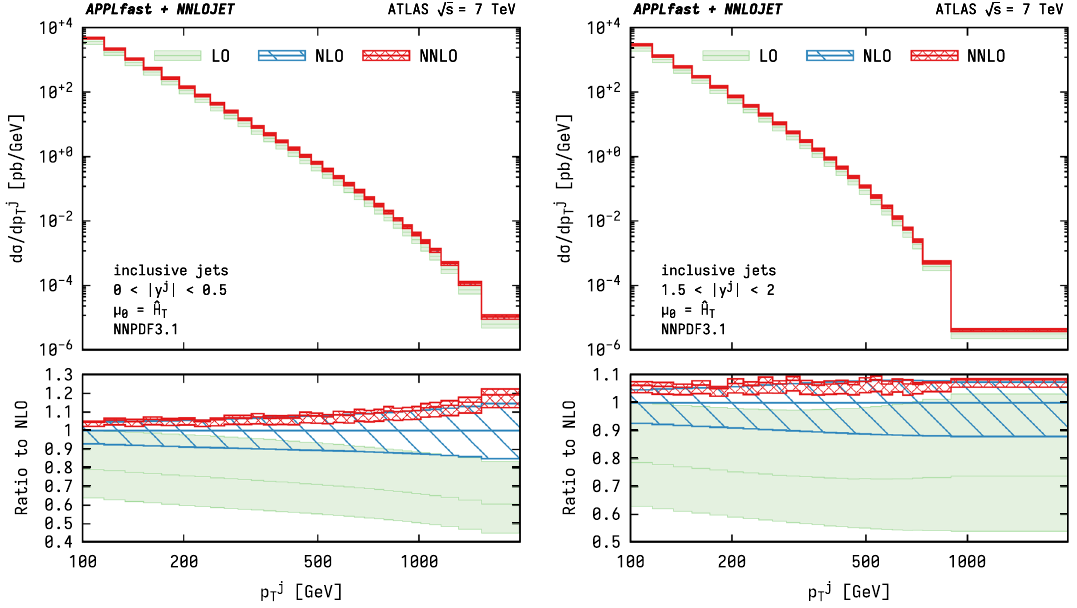
Fig. 2 PredictionsatLO,NLOandNNLOfortheATLAS7TeVinclu- in rapidity. The shaded bands show the scale uncertainties when using the recommended scale choice of μ = ˆ H T for inclusive jets. The lower for two representative ranges sive jet cross section as a function of p jet T panel displays the ratio with respect to the NLO